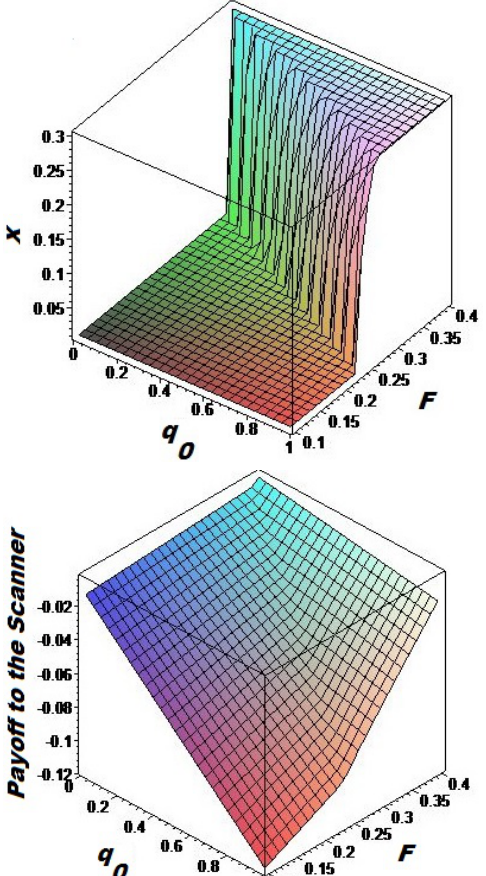
Figure 1. Equilibrium strategy x (upper) and payoff (bottom) to the Scanner.